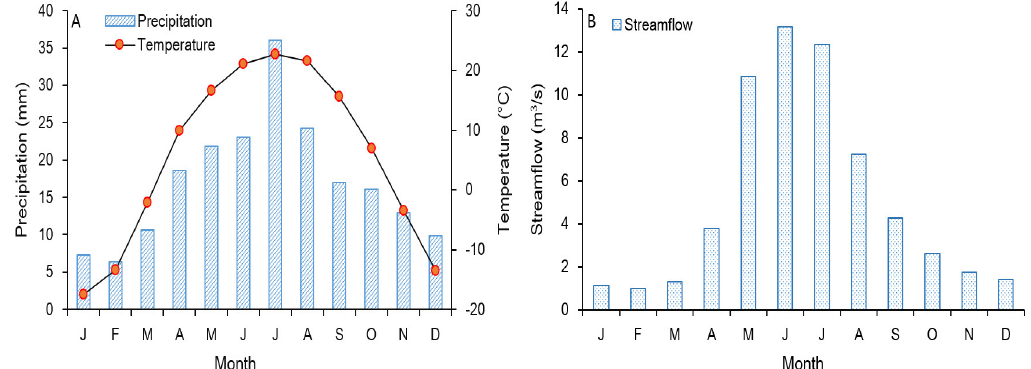
Figure 2. ( A ) Monthly total precipitation and monthly mean temperature records at the Qitai meteorological station from 1983 to 2013. ( B ) The monthly average streamflow of Kaiken River from 1983 to 2013.